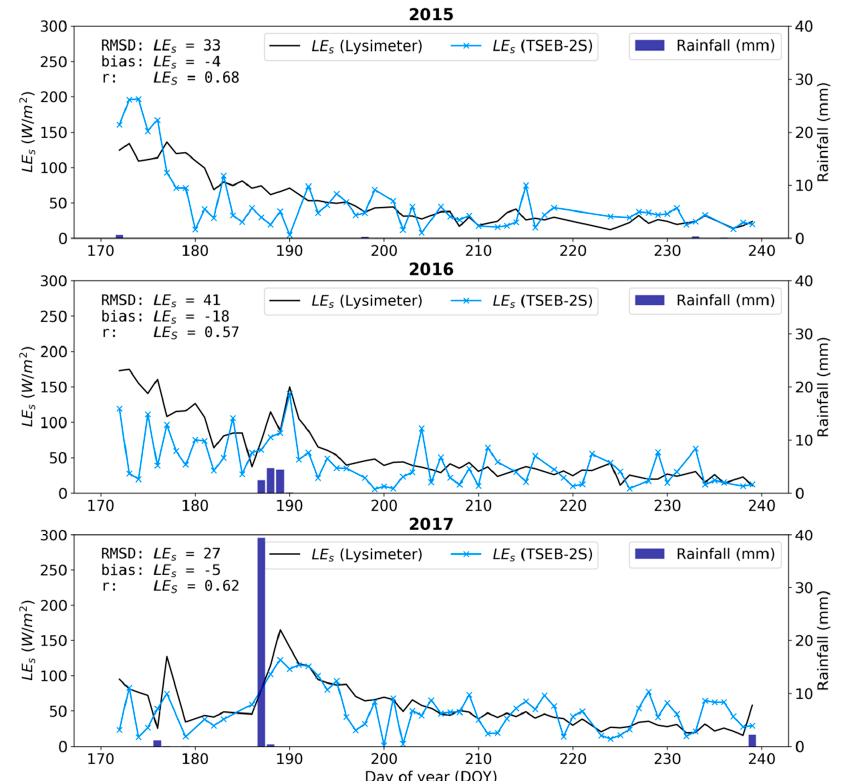
Figure 10. Time series of simulated (blue) and observed (black) daytime daily mean LE s at CT during the peak summer in 2015, 2016 and 2017 using TSEB-2S. LE measured by the lysimeter is assumed to be equivalent to LE s during the summer period due to grass senescence.